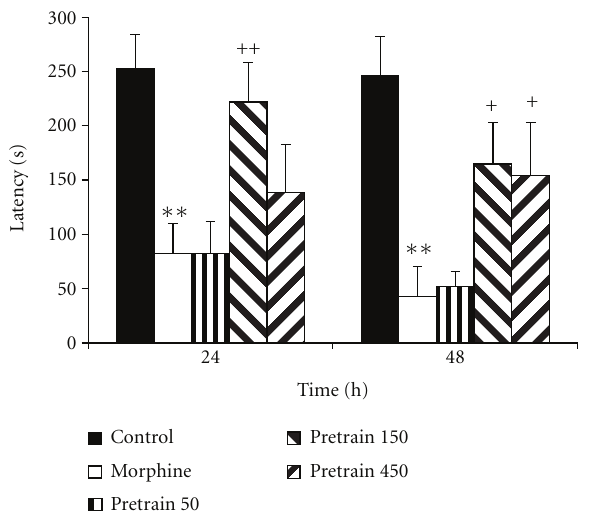
Figure 2: The e ff ects of pretraining injection of sa ff ron extract on the time spent in the dark compartment 24 and 48 h after receiving the shock. The animals of control group received saline instead of both sa ff ron extract and morphine. The animals of morphine group were treated by saline instead of SE but received morphine (5mg/kg, s.c.) 30min before the training phase. Pretrain 50, Pretrain 150, and pretrain 450 groups were treated by 50, 150, and 450 mg/kg of sa ff ron extract (i.p.), respectively, for 3 days before the training phase. The data were presented as mean ± SEM of the total time spent in the dark compartment (8 animals in each group). ∗∗ P < 0 . 01 compared with the control group; ++ P < 0 . 01 compared with the morphine